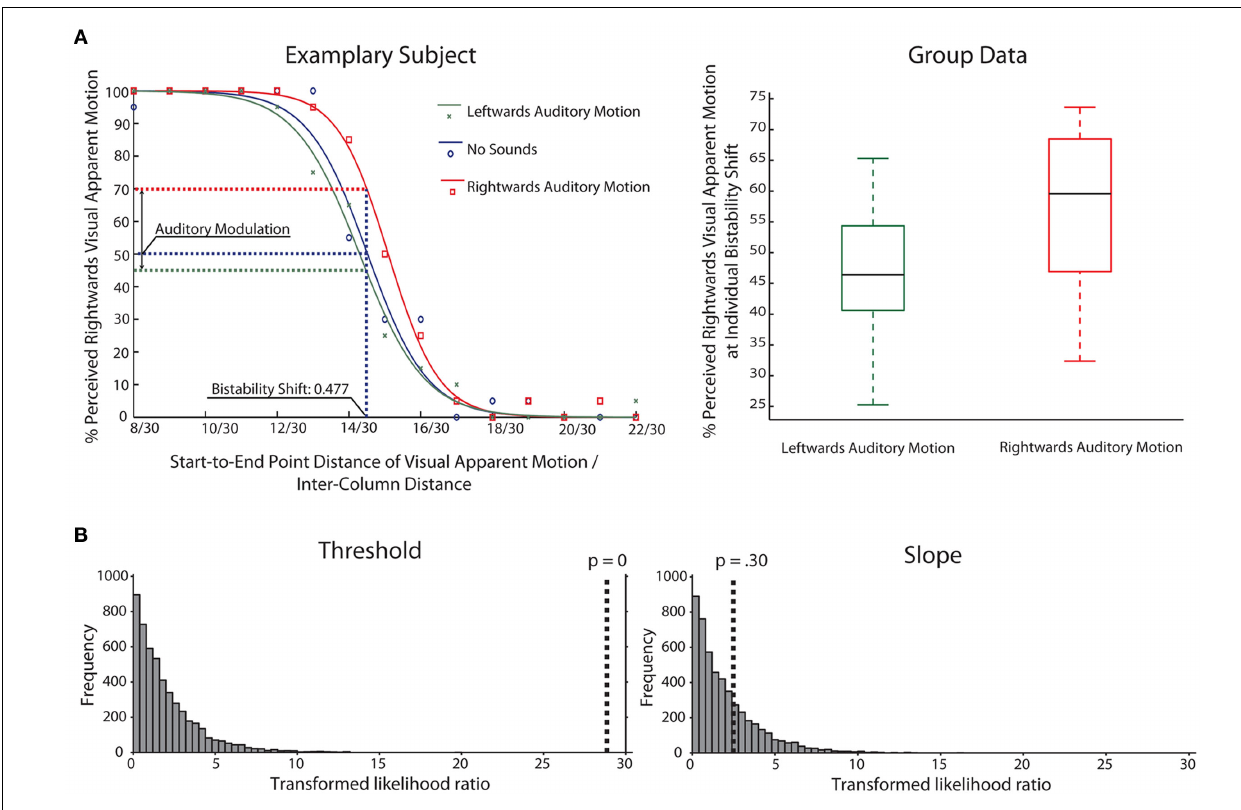
FIGURE 2 | (A) Left :This figure contains the plotted data for an exemplary participant (main experiment) and the fitted logistic functions for all three conditions.The visual apparent motion percept of this participant was estimated to be bistable for a shift of 0.477 of the inter-column distance. For this bistability shift the participant was estimated to perceive the visual apparent motion stimulus as moving rightward in 70% of the rightward auditory motion trials and in 46% of the leftward auditory motion trials. Right : Box-and-whisker diagrams depicting the group data for the main experiment for the percent perceived rightward visual apparent motion at the bistability